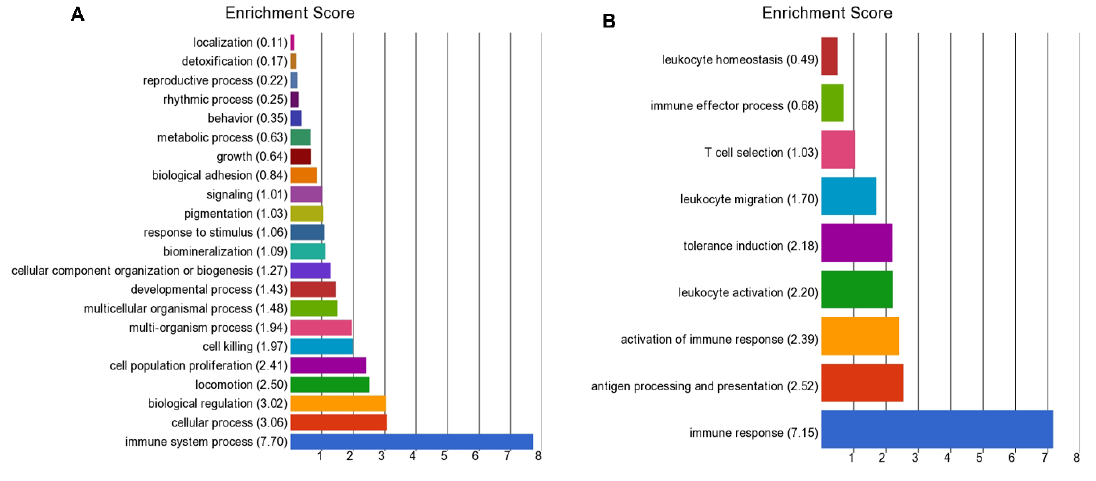
Figure 3. Gene Ontology (GO) enrichment analysis for ( A ) the differentially expressed genes (DEGs) by circulating leukocytes collected at around 14 days in milk between the low (1–200; n = 90) and high (>200; n = 24) BoHV-6 score cows and ( B ) sub analysis of the DEGs involved in immune system process.